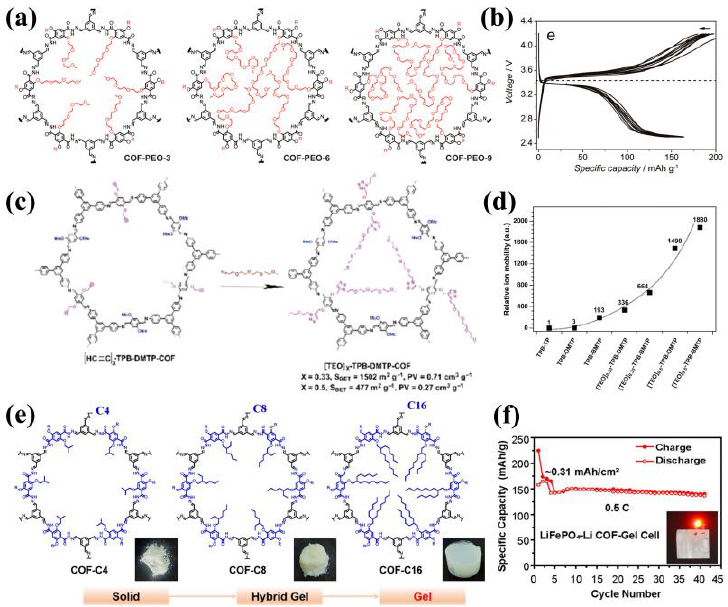
Figure 7. ( a ) Structure of COF − PEO − x (x = 3, 6, 9); ( b ) Charge-discharge curves of LiFePO 4 /COF- PEO − 9 − Li/Li cell at 100 °C. Reproduced with permission from Ref. [50], Copyright (2019), American Chemical Society; ( c ) Structure of [TEO]X − TPB − DMTP − COFs; ( d ) The relative ion mobility of Li + @TPB − TP − COF at 40 °C. Reproduced with permission from Ref. [51], Copyright (2020), John Wiley and Sons; ( e ) The structure of COF − Cx (x = 4, 8, 16); ( f ) Cycling performance of COF − gel − elec- trolyte in LiFePO4 − Li full cells at 0.5 C. Reproduced with permission from Ref. [52], Copyright (2021), John Wiley and Sons.